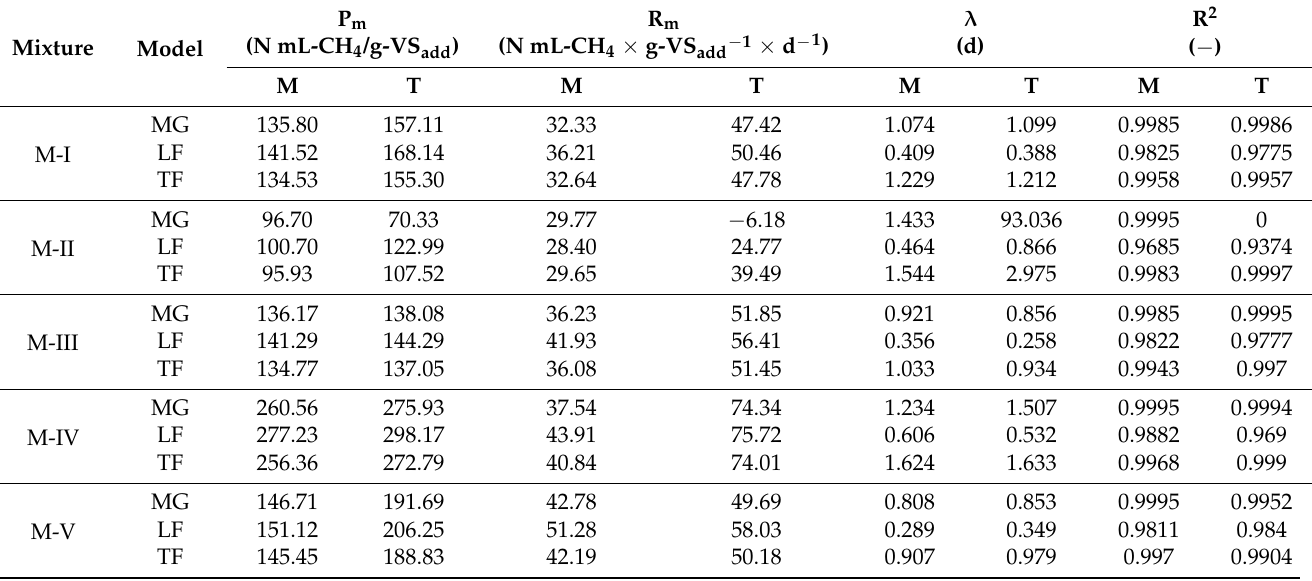
Table 4. Kinetic parameters that were determined by applying three mathematical kinetic models.